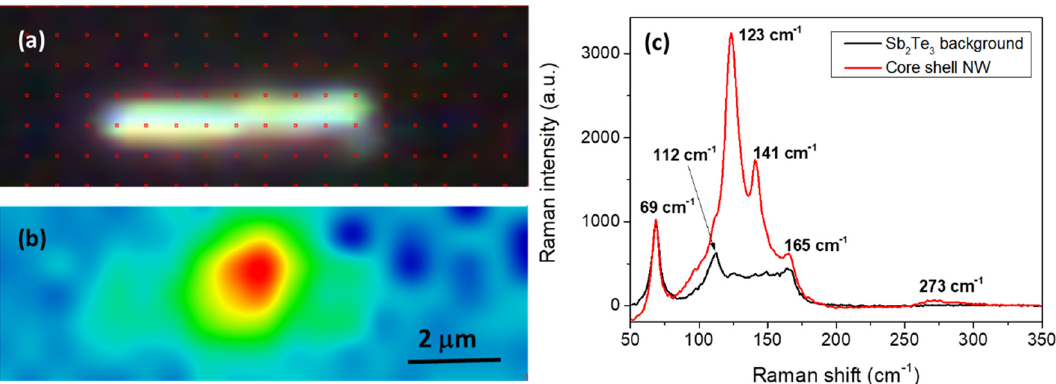
Figure 4. ( a ) Image of a GeTe/Sb 2 Te 3 core–shell NW, acquired with the optical microscope in dark field modality; the red points indicate the measuring array used to realize the 2D Raman map in ( b ). ( c ) Raman spectra corresponding to the Sb 2 Te 3 background (black line, and blue area of the map) and to the NW (red line, and green to red area in the map).